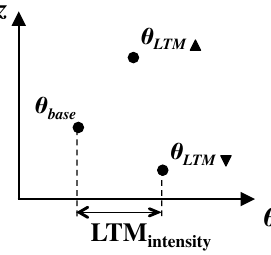
Figure 3. Illustration of the methodology used to identify LTM and quantify its